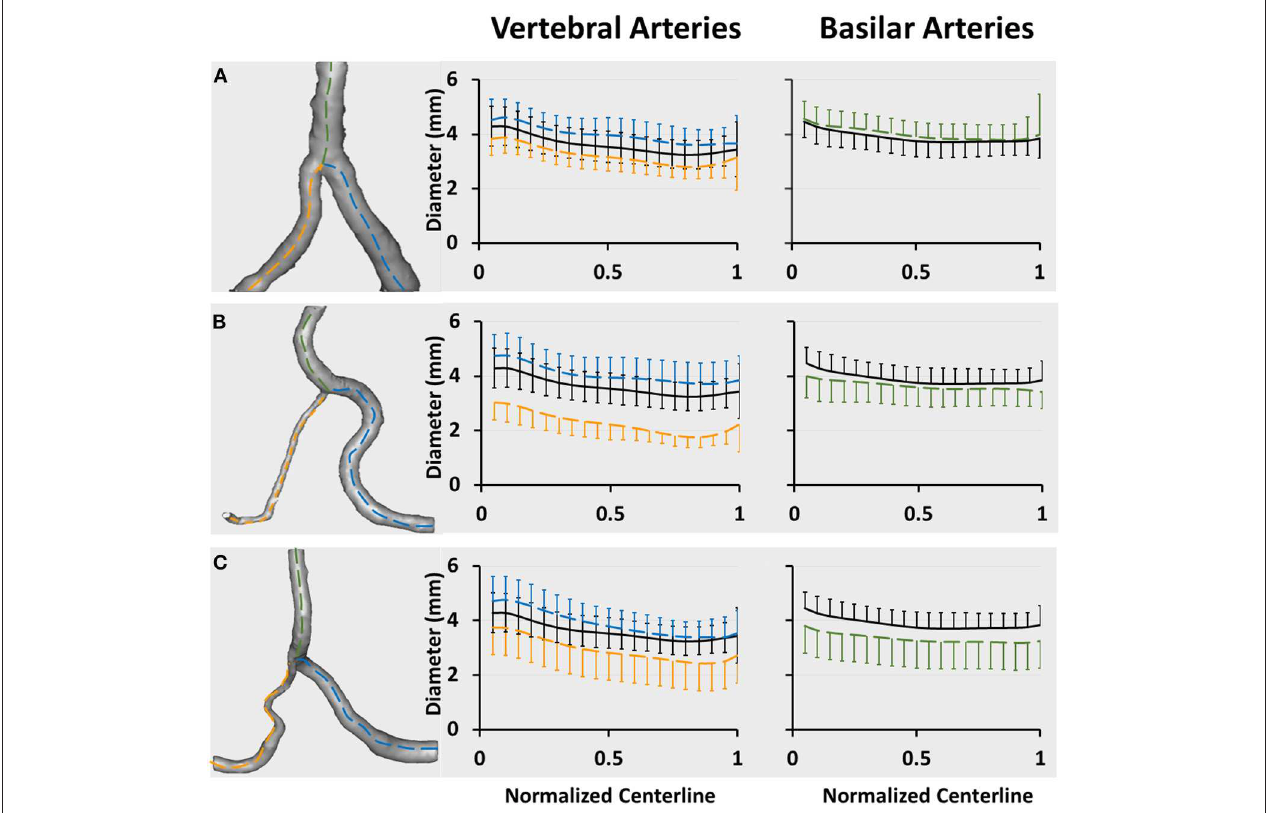
FIGURE 2 | Vertebrobasilar arteries reconstructed from patient CTA images and a plot of D fit along normalized vertebral artery and basilar artery centerlines in (A) asymmetric, (B) hypoplastic, and (C) stenotic groups. The vertebral artery centerlines are normalized by the accumulative length from the upstream inlet of left and right vertebral arteries (i.e., the centers of LVA 0 and RVA 0 in Figure 1B ) to the inlet of basilar artery (i.e., BA 0 in Figure 1B ). The basilar artery centerline is normalized by the accumulative length from the inlet of basilar artery (i.e., BA 0 in Figure 1B ) to the flow outlet of basilar artery (i.e., BA n in Figure 1B ). The black line refers to the mean value of D fit (averaged over 74 patients) in the symmetric group. The blue and yellow lines refer to the mean value of D fit along normalized vertebral arteries of large and small sizes, respectively. The green line refers to the mean value of D fit along the normalized basilar artery. The error bars refer to the standard